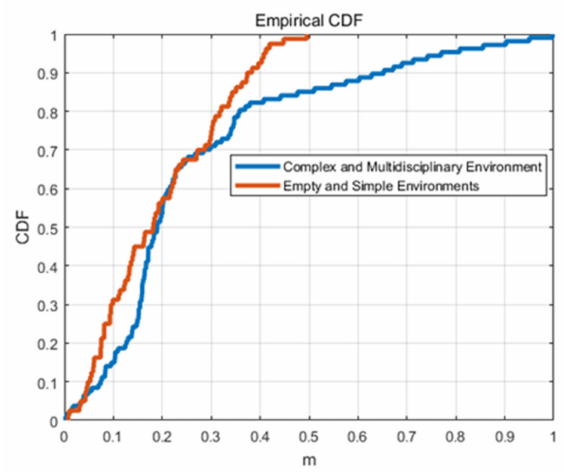
Figure 12. Error accumulation diagram of the trajectory errors in Environment 1 and Environment 2. (2) Tracking with unknown the starting position.